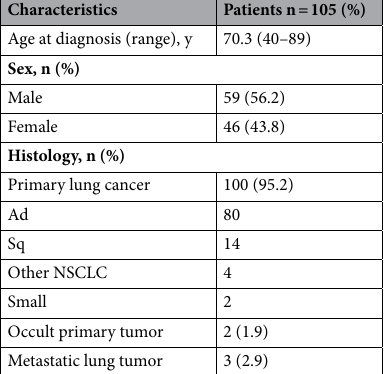
Table 1. Characteristics of the 105 cases in the study. NSCLC, non-small cell lung cancer; Ad, adenocarcinoma; Sq, squamous cell